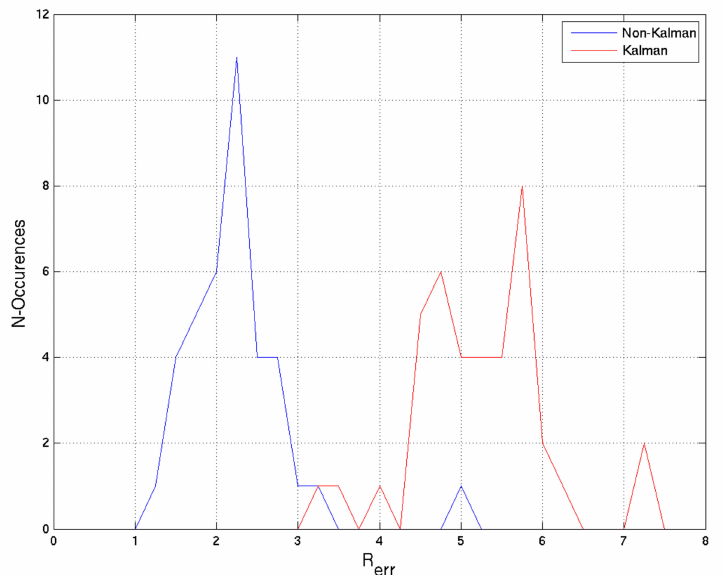
Figure 23. Histograms of the mean ratio of observed to estimated version 2.0 errors, averaged over each of the 39 surveys. Red and blue lines indicate Kalman and non-Kalman results,